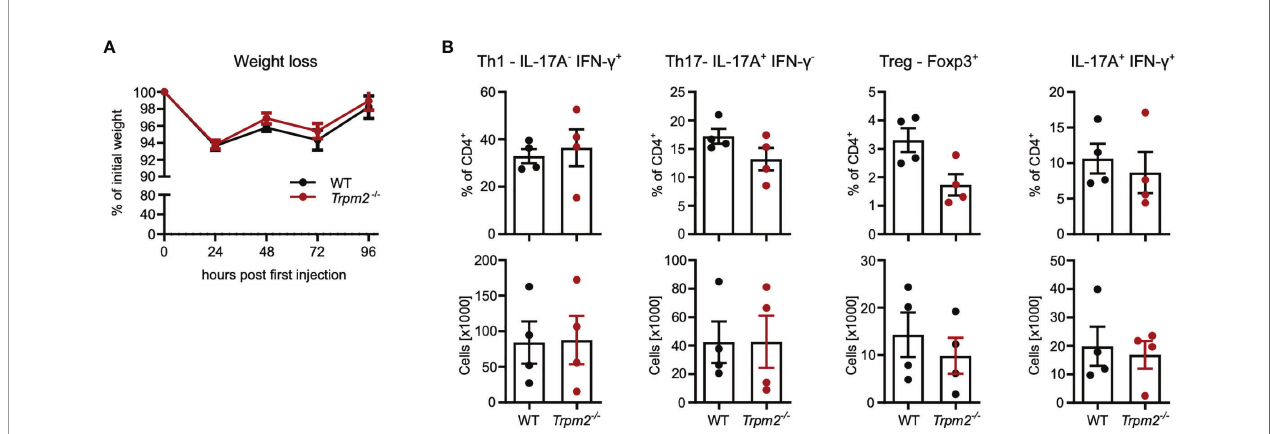
FIGURE 7 | TRPM2 de fi ciency does not impair response of transferred CD4 + T cells in the model of anti-CD3 mAb induced intestinal in fl ammation. Total CD4 + T cells from WT and Trpm2 -/- mice were transferred into Rag1 -/- mice. After 4 weeks, recipients were treated with anti-CD3 mAb on days 0, 2, and 4 and were analyzed 4 h after the last injection. (A) Percentage of initial body weight. (B) Frequencies and numbers of different CD4 + T-cell populations in the small intestinal mucosa. Bars depict mean ± SEM. Results were analyzed with the Mann – Whitney